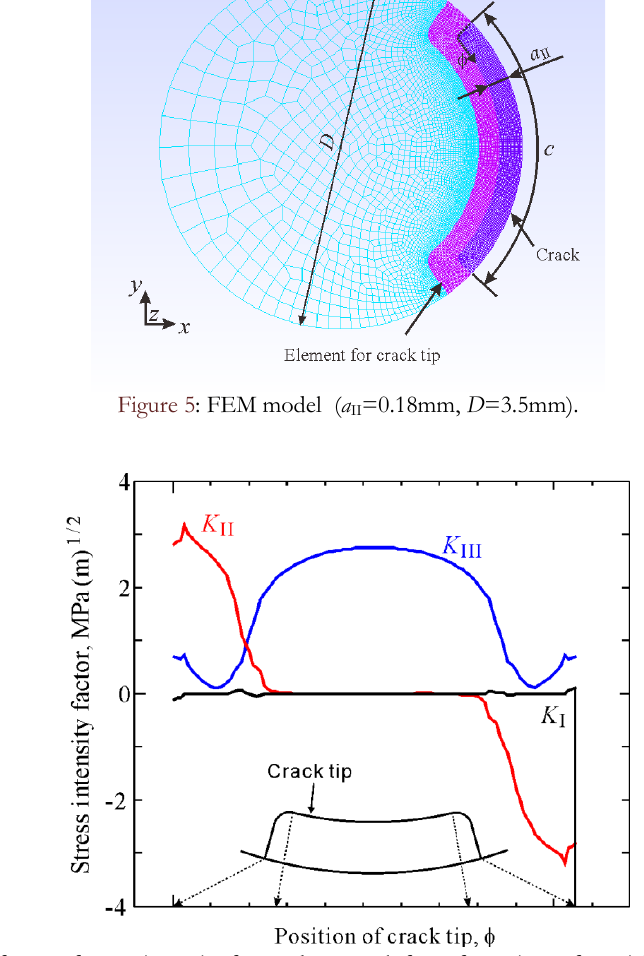
Figure 6: Stress intensity factor of stress intensity factor along crack front for a circumferential length c =0.25mm, 